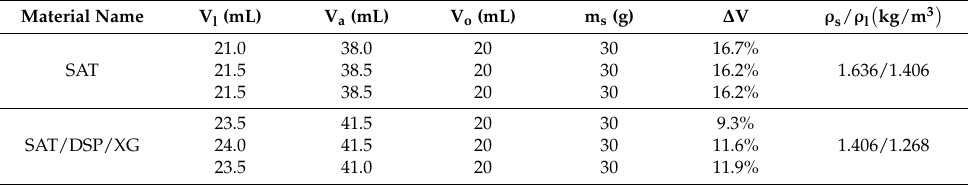
Table 2. Volume expansion rates and densities for pure SAT and modified